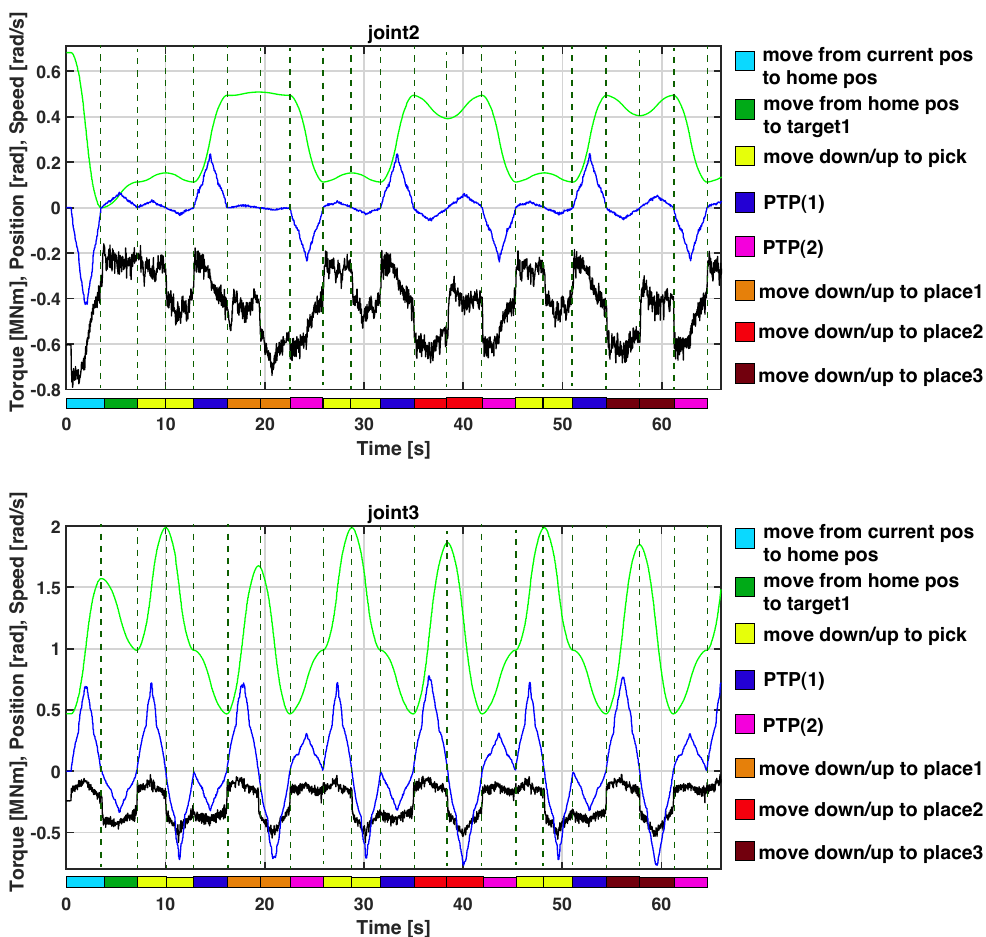
Figure 9. First, second, and third joints’ torque (in black), speed (in blue), and position (in green) acquired at 40 Hz for the 68.75 section (2750 samples each) during the execution of the palletizing program. The colors below the graph’s x axis represent the motion commands executed during the acquisition.